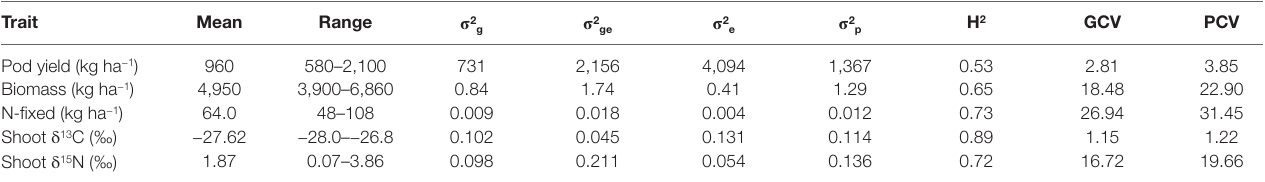
TABLE 6 | Estimates of mean, range, variance components, broad sense heritability, and genotypic and phenotypic coefficient of variation for selected traits of 21 groundnut genotypes grown in six environments. Trait